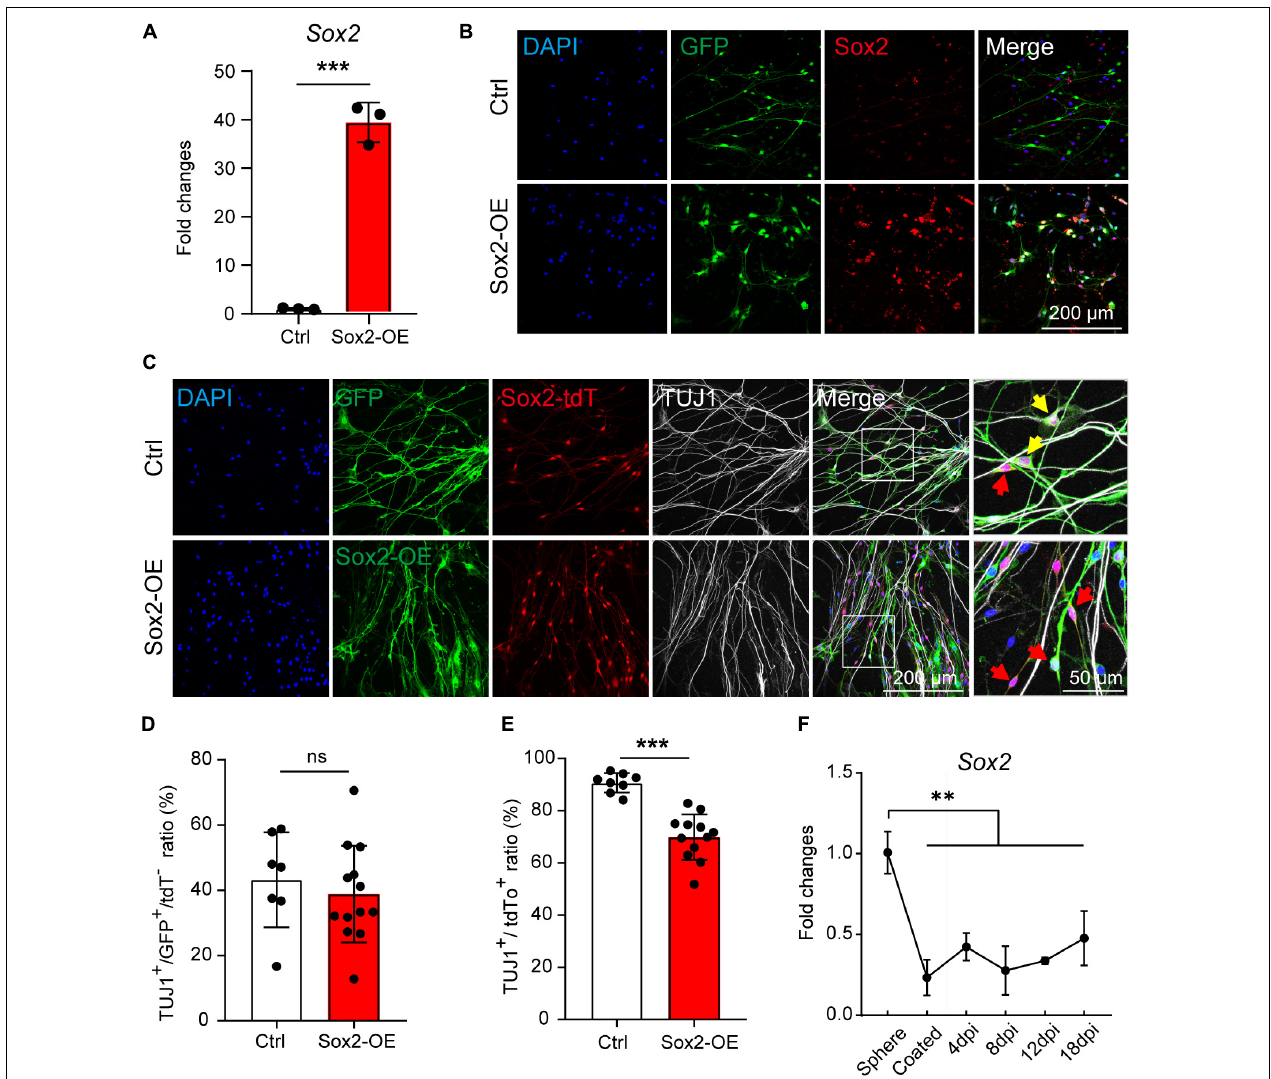
FIGURE 6 | Sox2 overexpression inhibits the neuronal differentiation of Sox2 + glial cells. (A,B) mRNA expression (A) and immunocytochemical staining (B) of Sox2 overexpressed in cochlear glial cells. N = 3, error bars represent mean ± SD. (C) Immunocytochemical staining of TUJ1 + neurons differentiated from cochlear glial cells of Sox2-tdT mice. The yellow arrows represent TUJ1 + /GFP + /tdT + cells, and the red arrows represent TUJ1 − /GFP + /tdT + glial cells. (D) Quantification of TUJ1 + /GFP + cells from Sox2-tdT negative glial cells. N = 8–13 images from 3 coverslips, error bars represent mean ± SD. (E) Quantification of TUJ1 + /Sox2-tdT + cells from glial cells overexpressing either GFP or Sox2. N = 7–11 images from 3 coverslips, error bars represent mean ± SD. (F) mRNA expression of Sox2 during induced neuronal differentiation of the cochlear glial cells at different conditions and time points. N = 3, error bars represent mean ± SD. ** p < 0.01, *** p < 0.001 by one-way ANOVA (F) or unpaired student’s t -test (A,E)